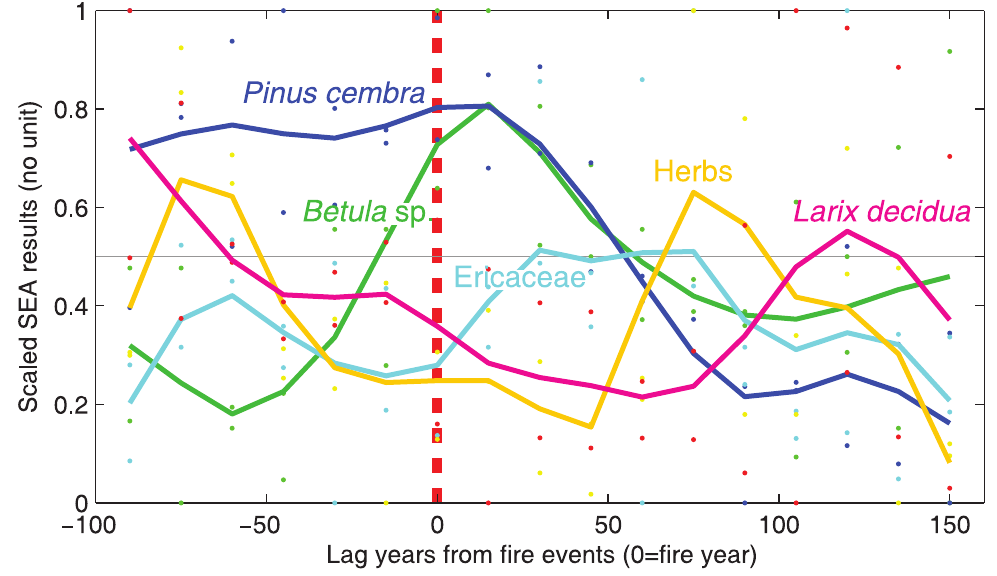
Figure 3. Modeled behavior of plants pre- and post-fire using Superposed Epoch Analysis summarized results for the two lakes. SEA means were transformed using min/max scaling followed by LOWESS curve fitting to highlight macroremains trajectories by species for the two lakes.